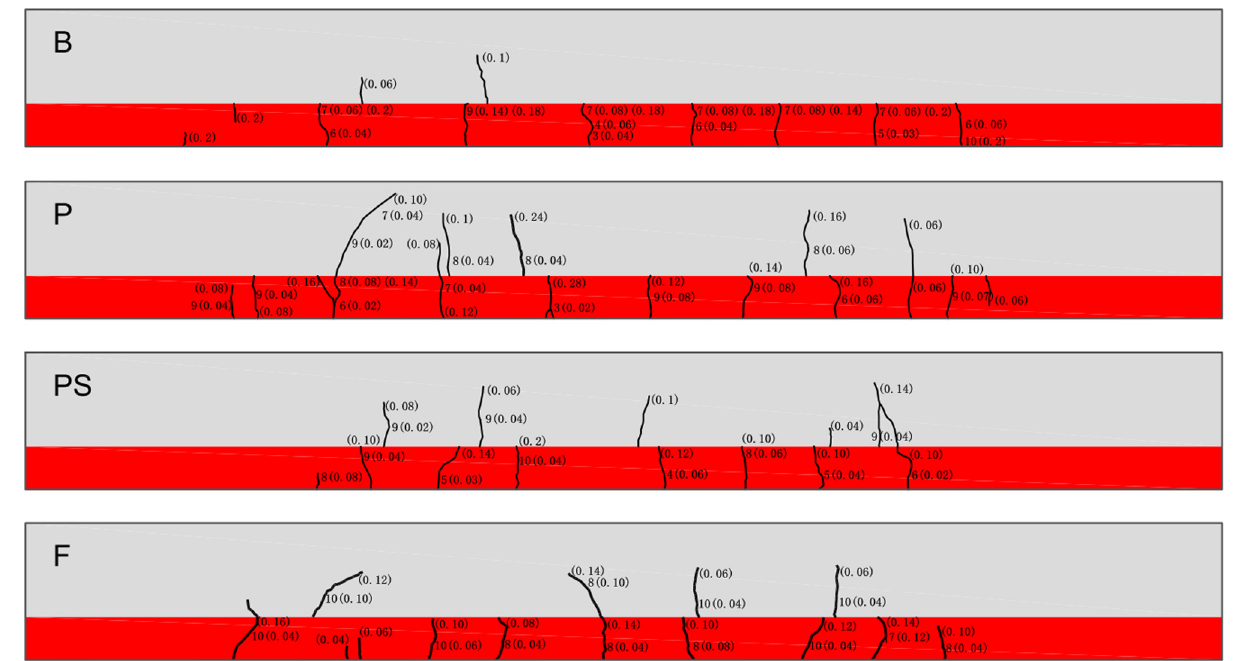
Figure 11: Development of cracks in the repaired beams.